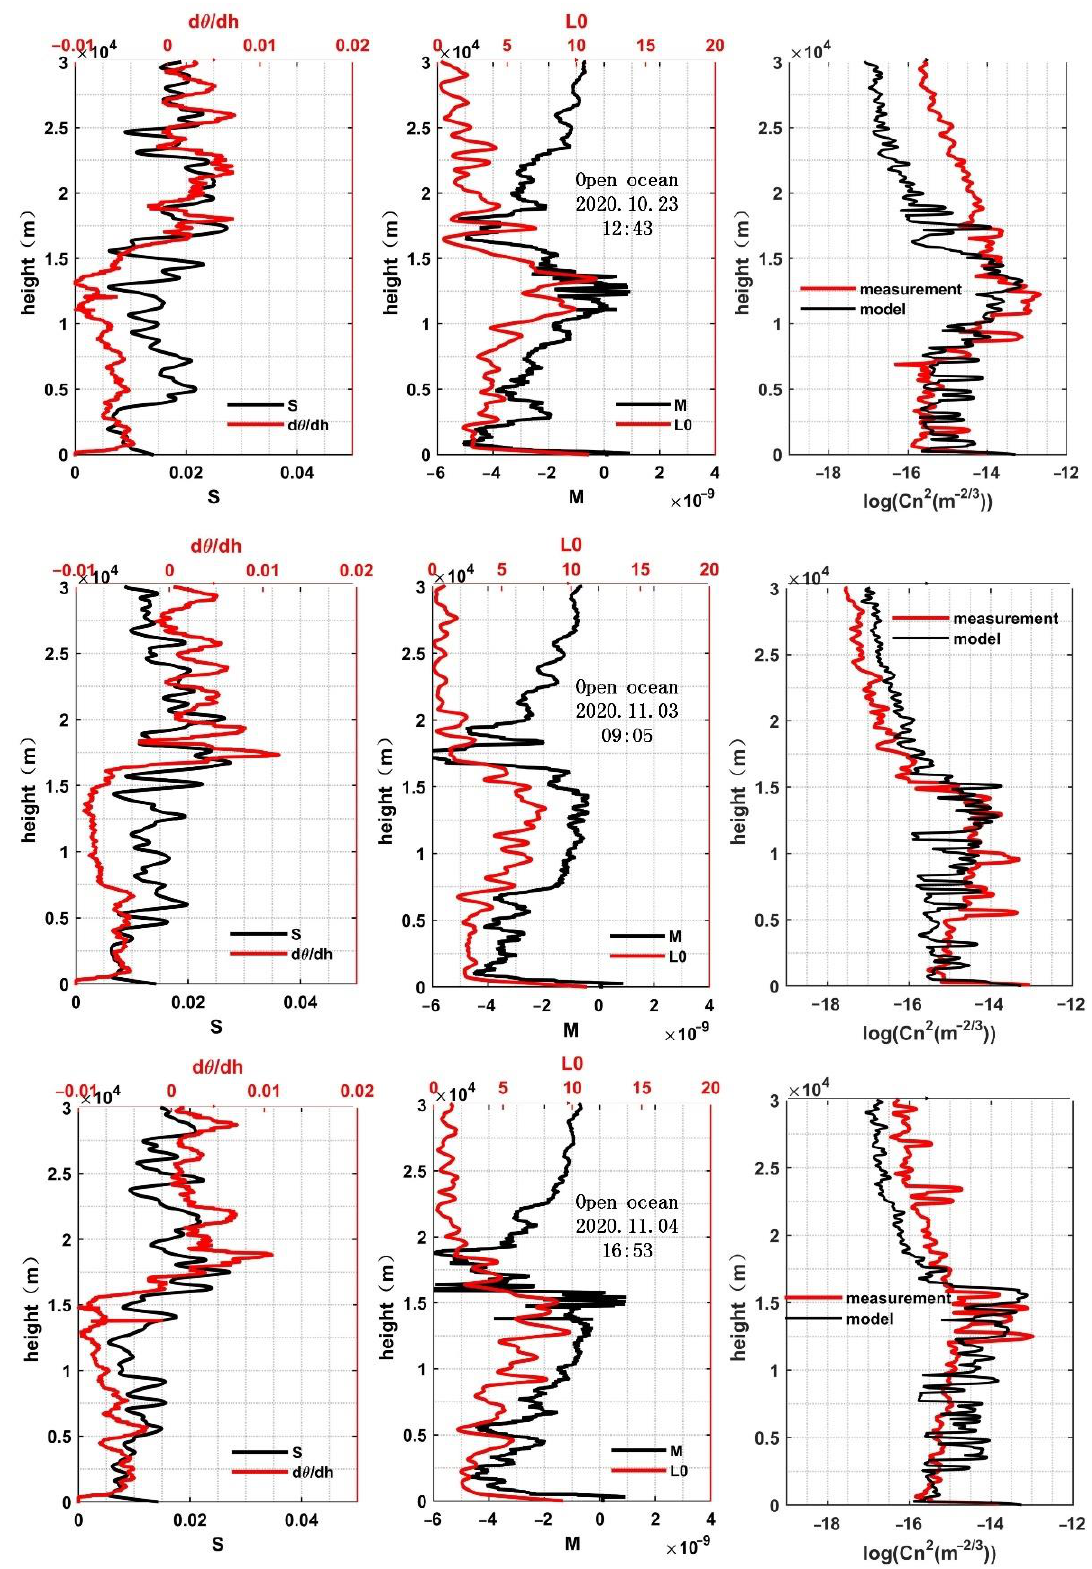
Figure 5. The profiles of temperature gradient, wind shear ( left ), outer scale and potential refractive index gradient ( middle ) as well as C 2 n profiles of estimated and measured ( right ) in open ocean.